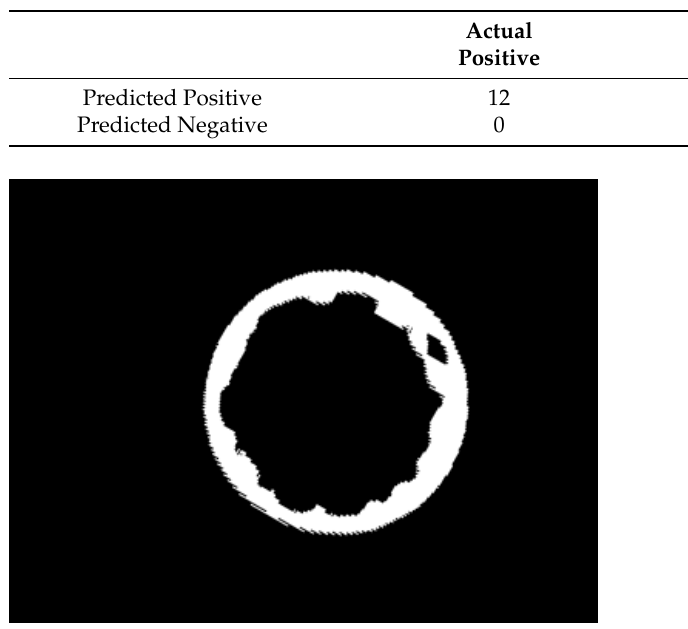
Table 3. Confusion matrix for the test set.